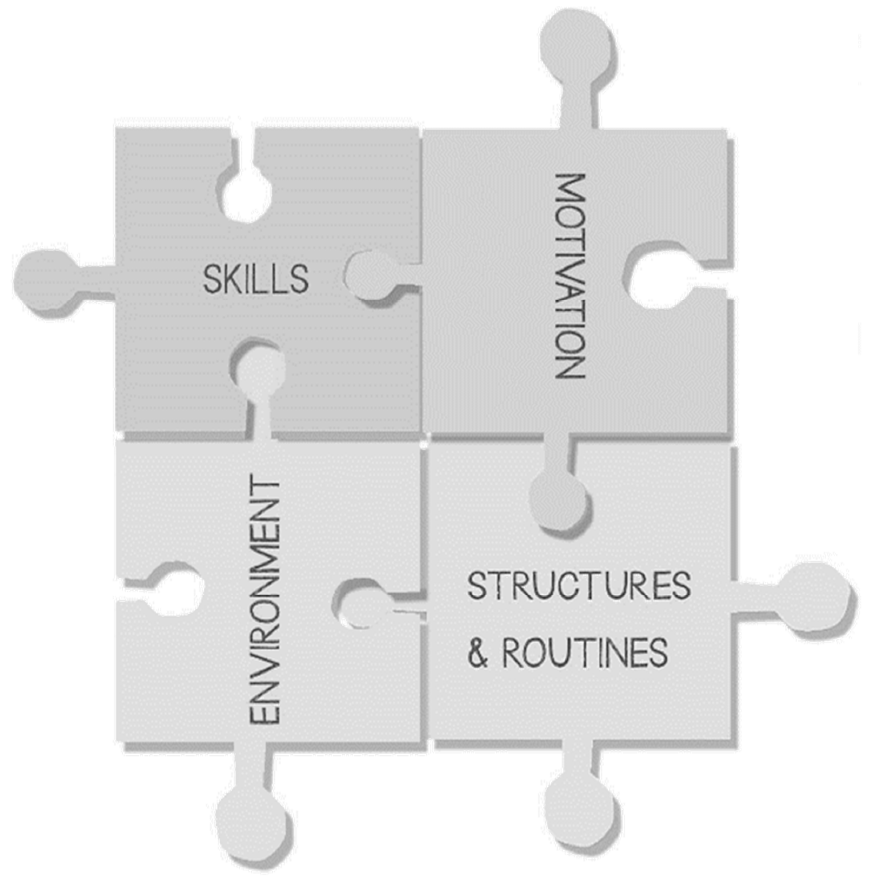
Figure 2. Updated CIRCLE framework. Reproduced from CIRCLE manuals [46,47]. Table 1. Overview of CIRCLE framework components *.